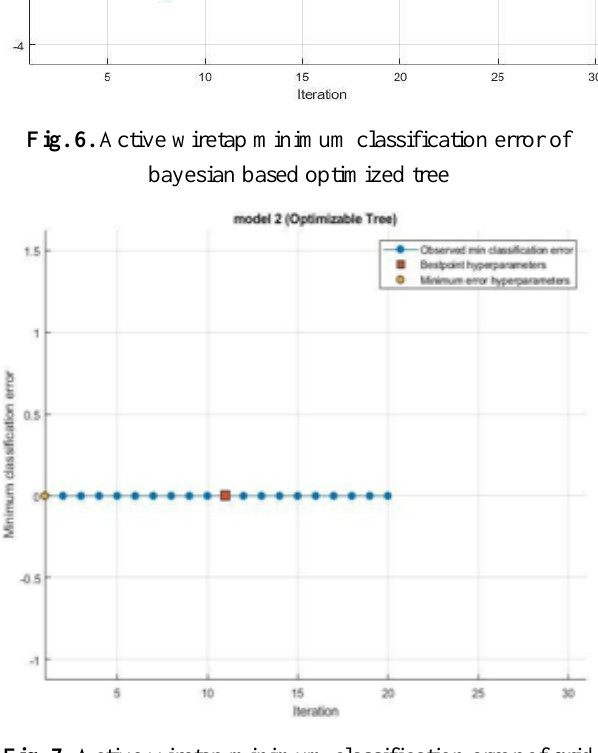
Fig. 10. ARP MitM minimum classification error of grid search based optimized tree